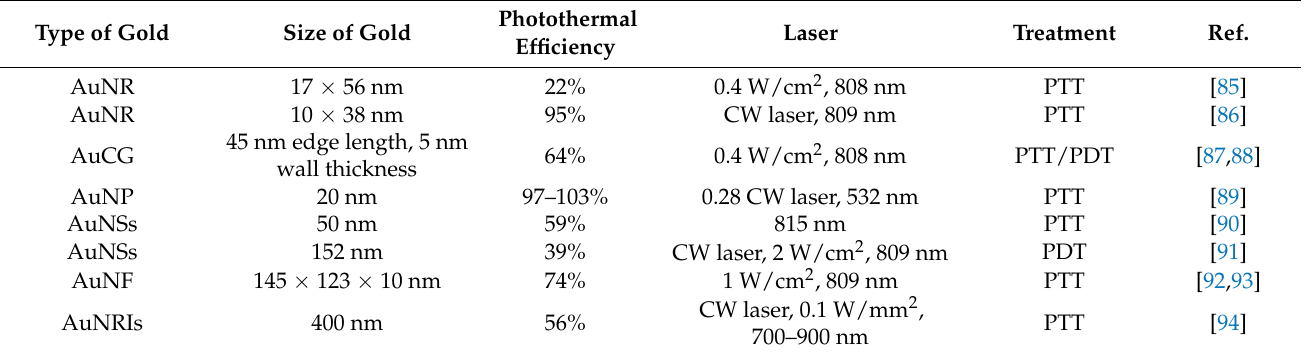
Figure 4. Extinction spectra of Au nanostructures. ( A ) Spectra of (a) nanospheres, (b) nanocubes, and nanorods with aspect ratios of (c) 2.4 ± 0.3, (d) 3.4 ± 0.5, and (e) 4.6 ± 0.8, respectively. ( B ) Spectra of nanobipyramids with aspect ratios of (a) 1.5 ± 0.3, (b) 2.7 ± 0.2, (c) 3.9 ± 0.2, and (d) 4.7 ± 0.2, and (e) nanobranches [84] . Reproduced with permission from [84] . American Chemical Soci- ety, 2008. Table 2. Summary of photothermal conversion efficiency of gold nanoparticles for PTT and PDT. A correlation between size, morphology, and photothermal conversion efficiency.